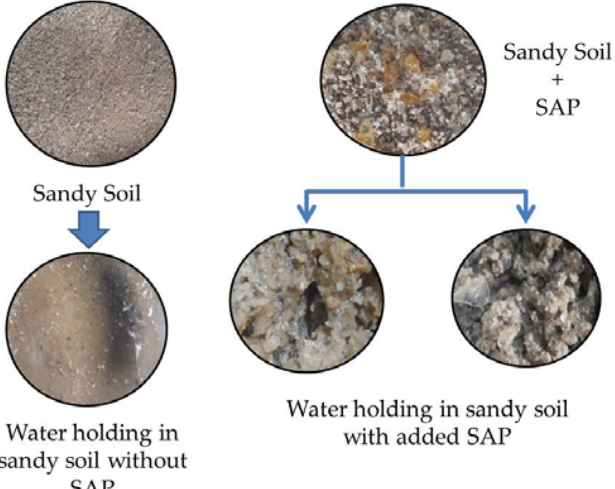
Figure 9. Differences in the water ‐ holding characteristics of sandy soil with and without SAP ad ‐